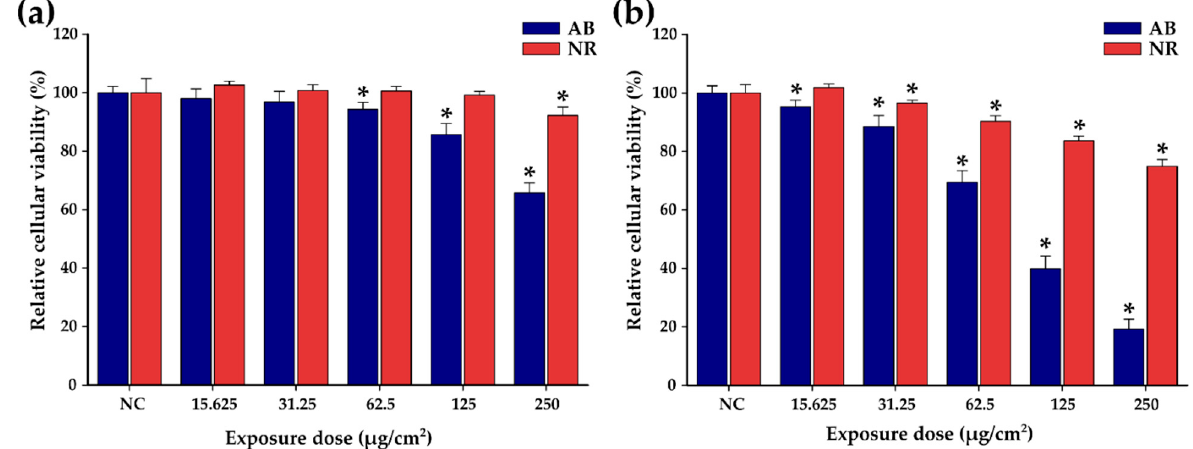
Figure 5. Cytocompatibility of ( a ) l-DOX-TsMLs and ( b ) h-DOX-TsMLs on A549 cell line after 48h exposure. Data are presented as relative values to the negative control (100%), as mean ± SD of three biological replicates. The significant differences compared to the negative control (ANOVA + Dunn’s; p < 0.05) are noted with asterisks (*).